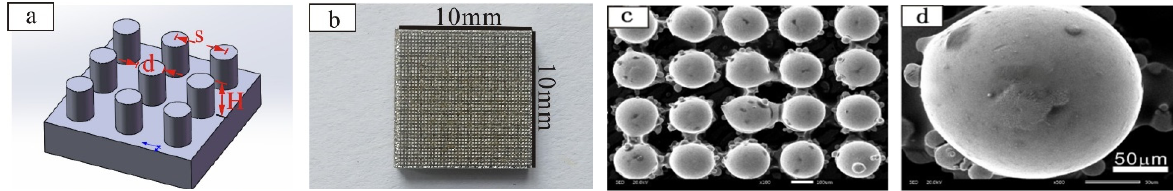
Figure 1. The cylindrical array structure. ( a ) Model; ( b ) printed entity; ( c ) SEM image magnified 100 times; ( d ) SEM image magnified 500 times.